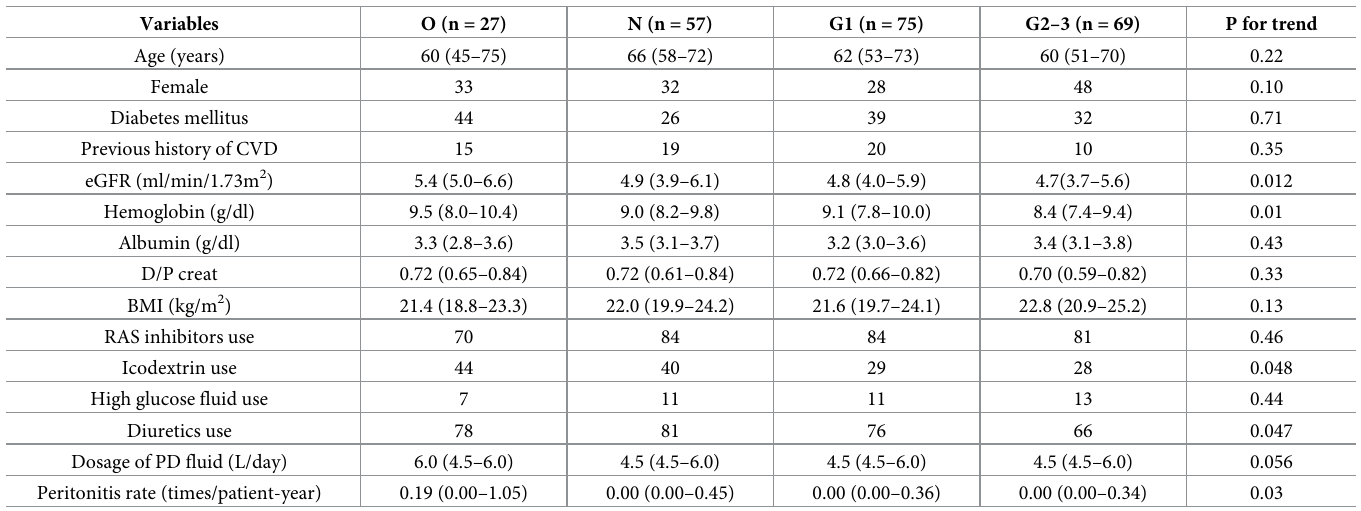
Table 1. Baseline characteristics of the patients by the graded BP